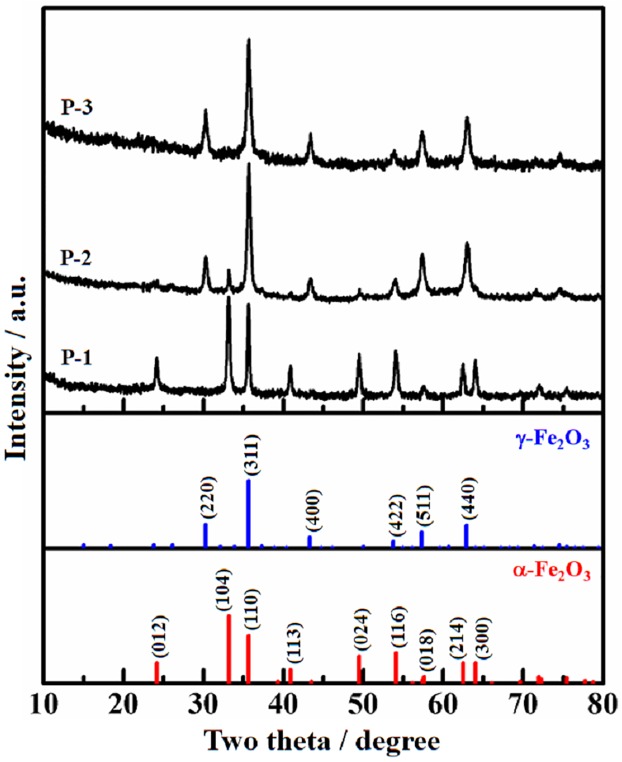
XRD patterns of the precursors, as well as the standard data for α-Fe2O3 and γ-Fe2O3.